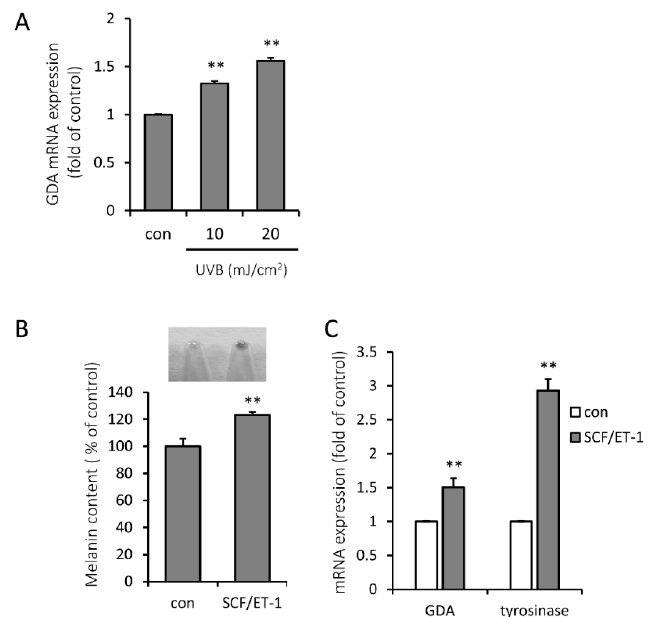
Figure 3. UVB irradiation and stem cell factor (SCF) / endothelin-1 (ET-1) upregulates guanine deaminase (GDA) expression. ( A ) GDA mRNA expression was increased in UVB-exposed normal human keratinocytes (NHKs) in a dose-dependent manner at 24 h. ( B ) Melanin content was significantly increased in the coculture of NHKs and normal human melanocytes (NHMs) when stimulated by 10 ng / mL SCF and 0.1 nM ET-1 for 5 d. ( C ) GDA and tyrosinase mRNA expression levels were increased by treatment with 10 ng / mL SCF and 0.1 nM ET-1 for 5 d in a coculture of NHKs and NHMs. ** p < 0.01. 2.4. siGDA in KCs Downregulates Melanogenesis While GDA Overexpression Promotes Melanogenesis in the